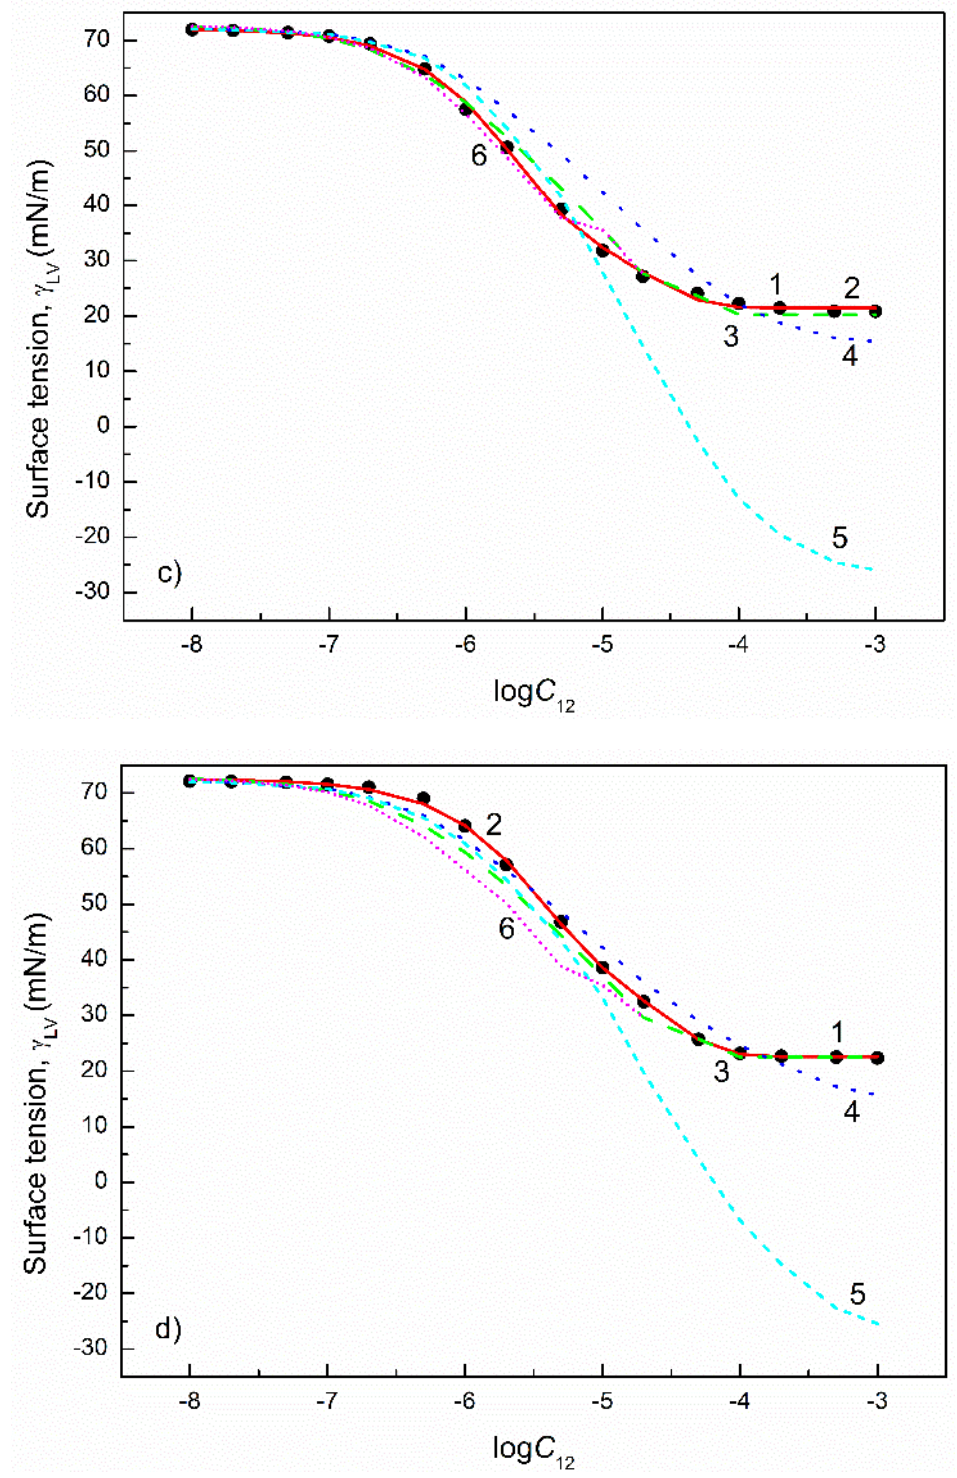
Figure 8. A plot of the surface tension ( γ LV ) of the aqueous solutions of FC1+FC2 mixtures at the FC2 mole fraction in the bulk phase ( α ) equal to 0.2 ( a ), 0.4 ( b ), 0.6 ( c ) and 0.8 ( d ) vs. the logarithm of the mixture concentration ( logC 12 ). Points 1 correspond to the measured values [30], curves 2–6 correspond to the values calculated from the exponential function of the second order (Equation (2)), Szyszkowski equation (Equation (3)), Fainerman and Miller equation (Equation (11)), independent adsorption (Equation (10)) and Joos equation (Equation (13)), respectively.